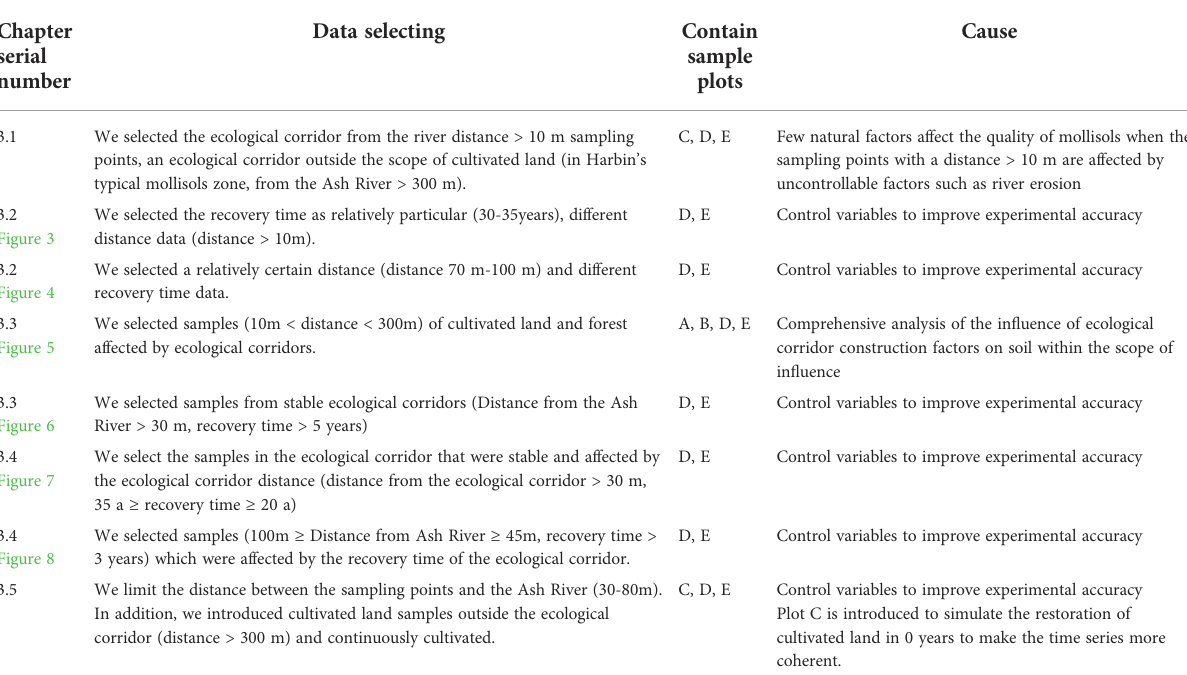
TABLE 3 Screening of raw